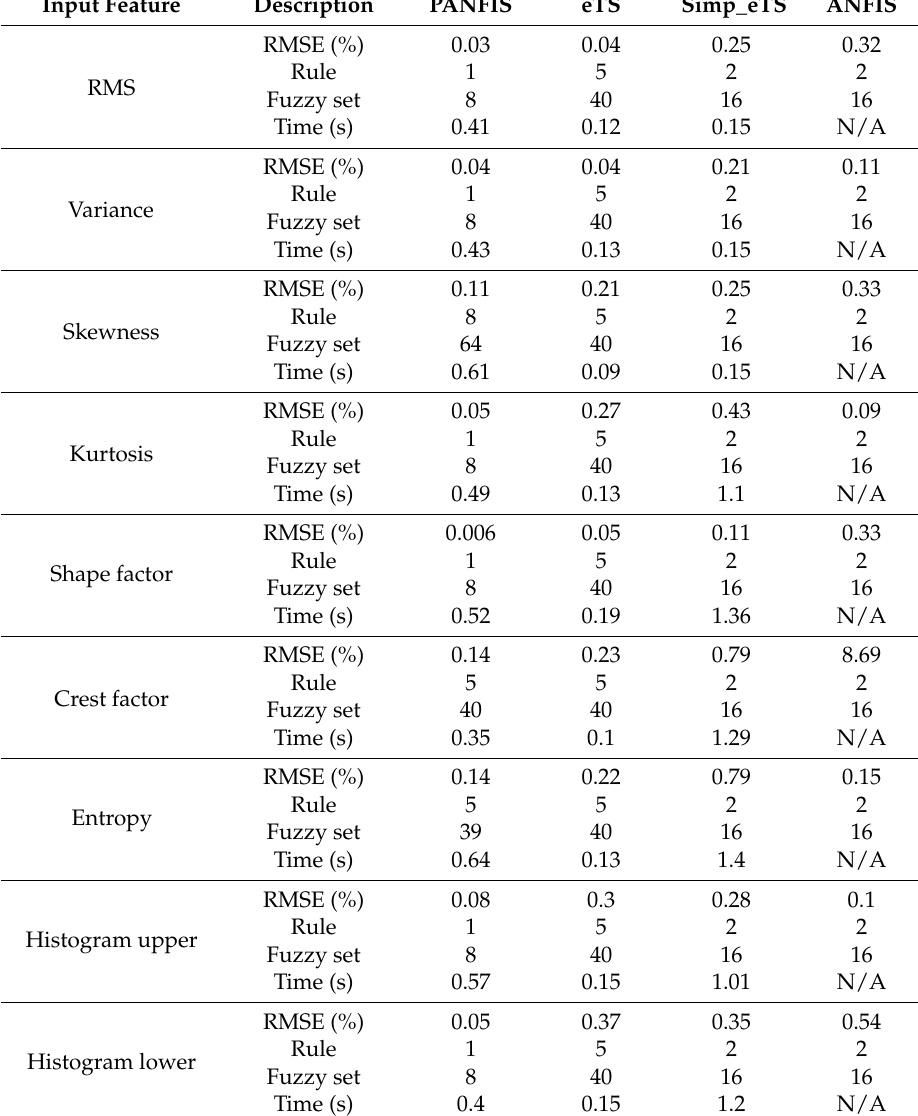
Table 2. Numerical results using direct partition scenario.